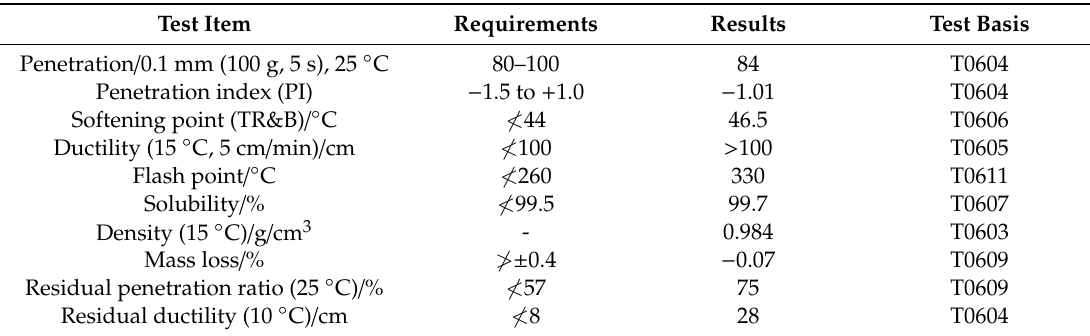
Table 1. Physical properties of KL-90# asphalt.